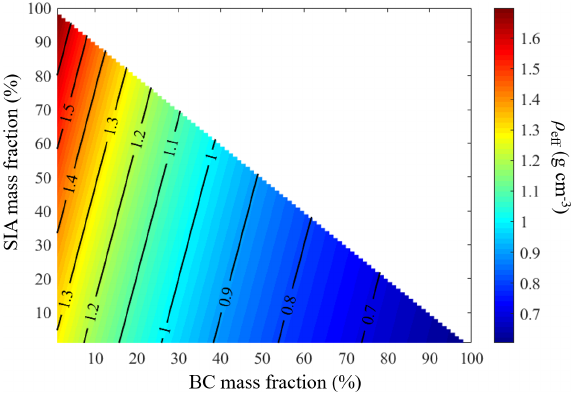
Figure 10. Particle effective density ( ρ eff ) calculation based on as- sumed chemical